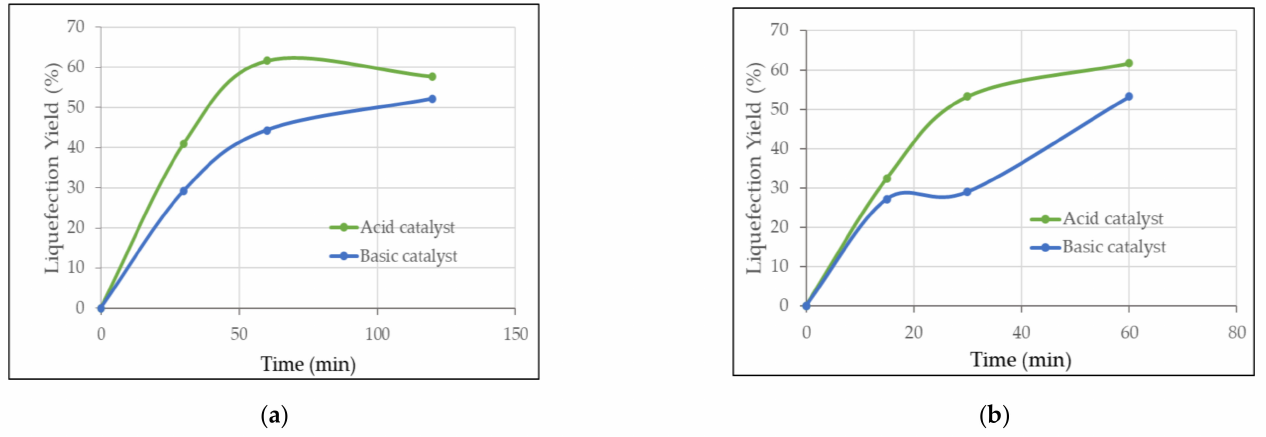
Figure 2. Effect of the catalyst on the liquefaction yields from ( a ) bark and ( b ) branches for the fraction > 80 mesh (powder) at 180 ◦ C.